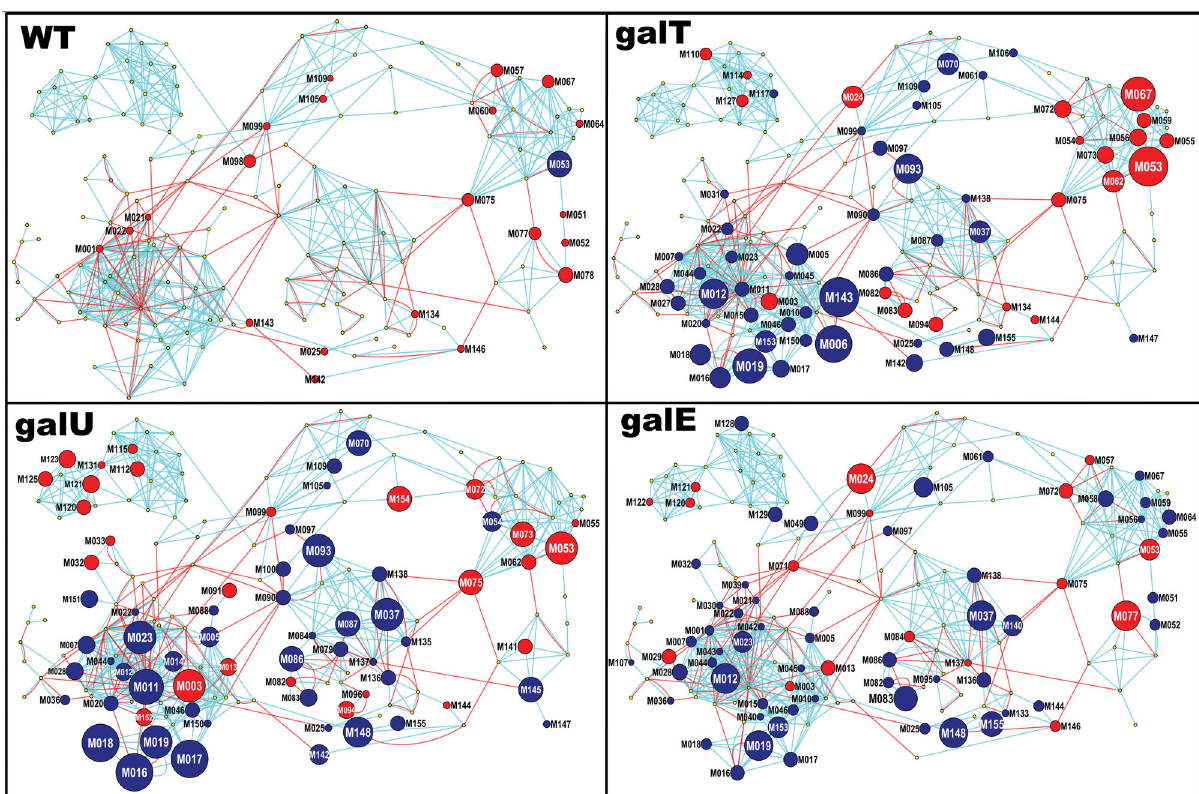
Figure 3. MetaMapp of the metabolic modules that were altered in E. coli grown in galactose. Each node is a metabolite, blue edges are chemical similarity links and red edges are KEGG RPAIR links as calculated by the MetaMapp software. Red nodes represent significantly increased metabolites, and blue nodes represent significantly decreased metabolites. Node sizes reflect the magnitude of fold change as provided in Tables S2-S5. Cytoscape organic layout algorithm was used to visualize the network graph, and results of Welch’s two sample T-test were overlaid on the graph. Labels of different modules are provided in the graph of wild-type strains. To maintain the clarity of the graph, metabolite labels were provided in Tables S2-S5 and in the graph metabolites are referenced with a number. Labels of big nodes are as follows: M053:galactose, M0067:glucose, M077:UDP-galactose, M073:glc/frc-1,6-bisphosphate, M075:ribose, M037:MTA, M093, Succinyl CoA, M143:dihydrooratate,